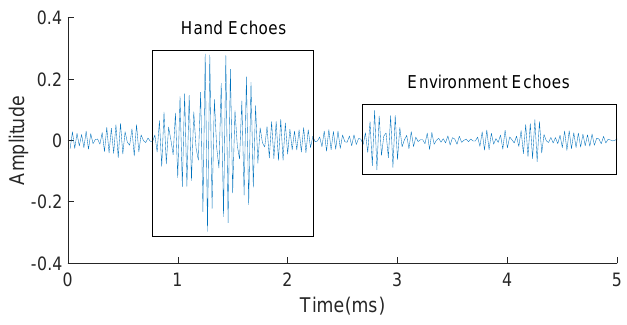
Figure 7. Separation of hand echoes and environment